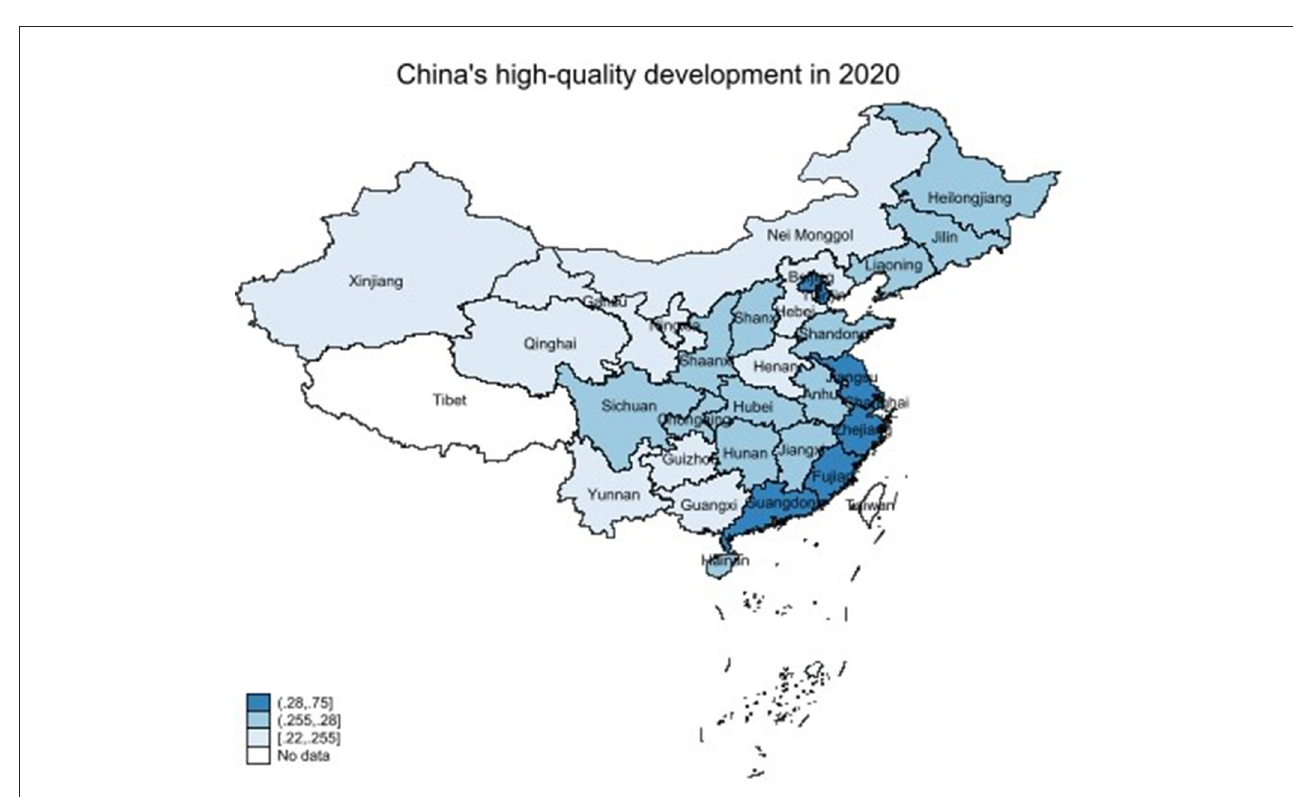
FIGURE1 Regional distribution of high-quality